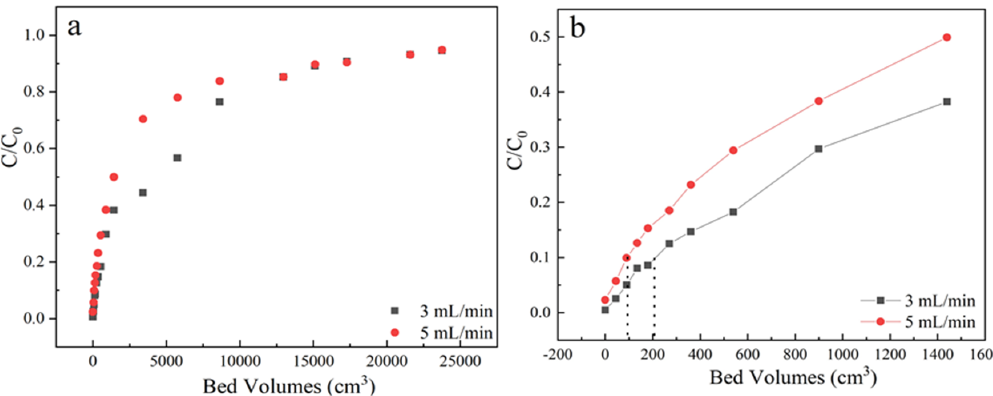
Figure 4. ( a ) The adsorption effect of different flow rate on breakthrough curves; ( b ) Partially enlarged screening from 0 to 1600 bed volume. Experiment condition: sulfamethoxazole concentration of 35 mg/L, pH 6.5, column height of 3 cm, flow rate of 3, 5 mL/min, respectively.